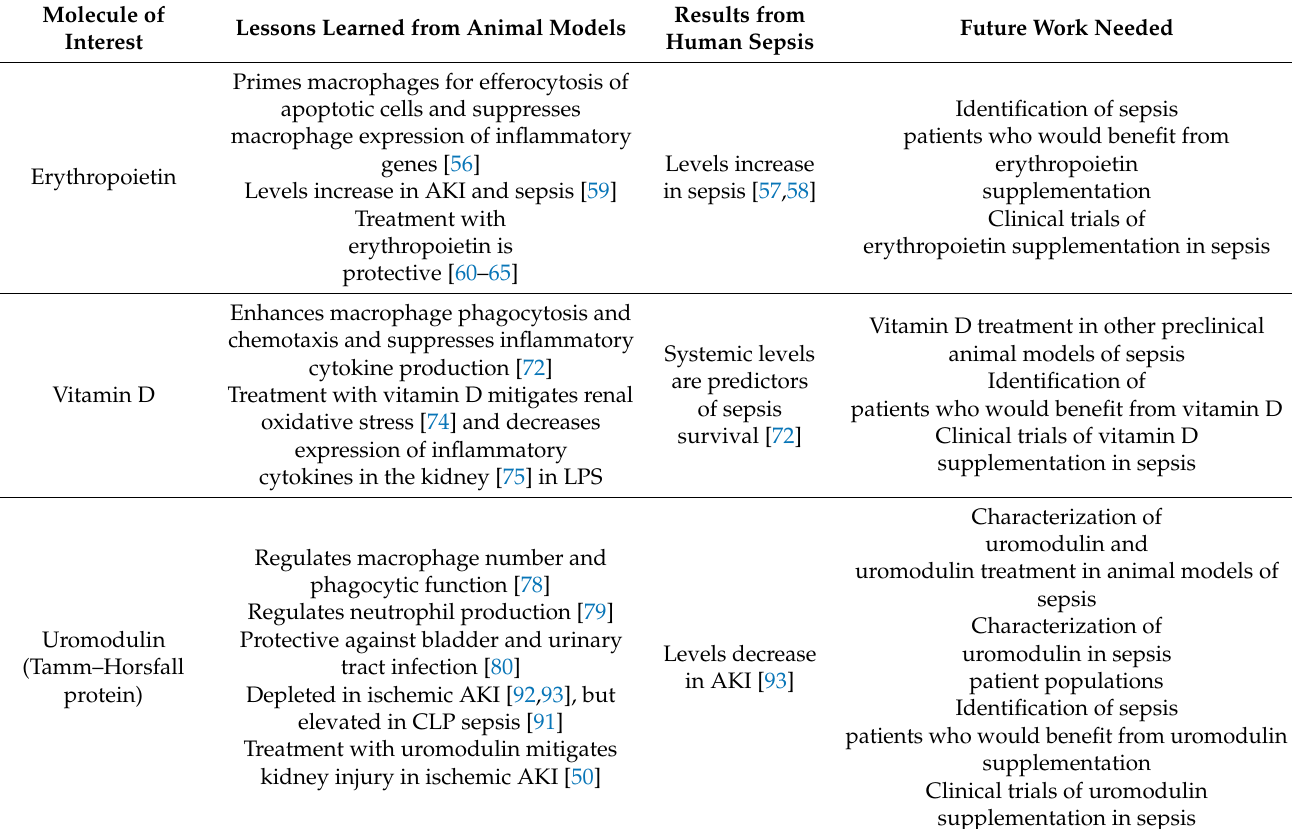
Table 1. Kidney-derived molecules that could mediate kidney–immune crosstalk in